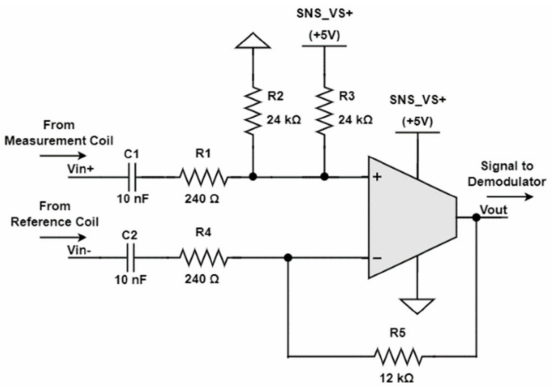
Figure 8. Preamplifier simplified